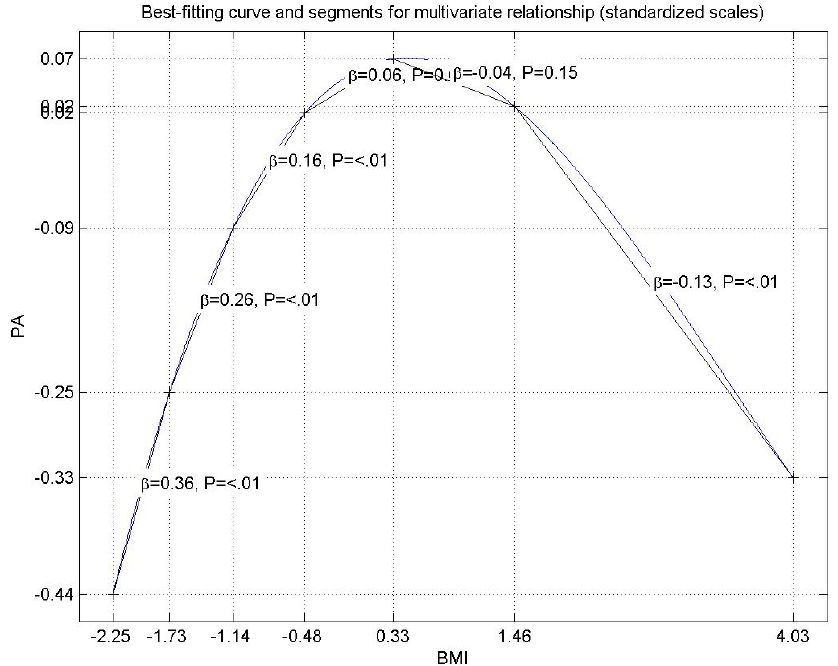
Figure 2. The non-linear relationship between the amount of time people engage in physical activi- ties (PA) and body mass index (BMI). (PA) and body mass index